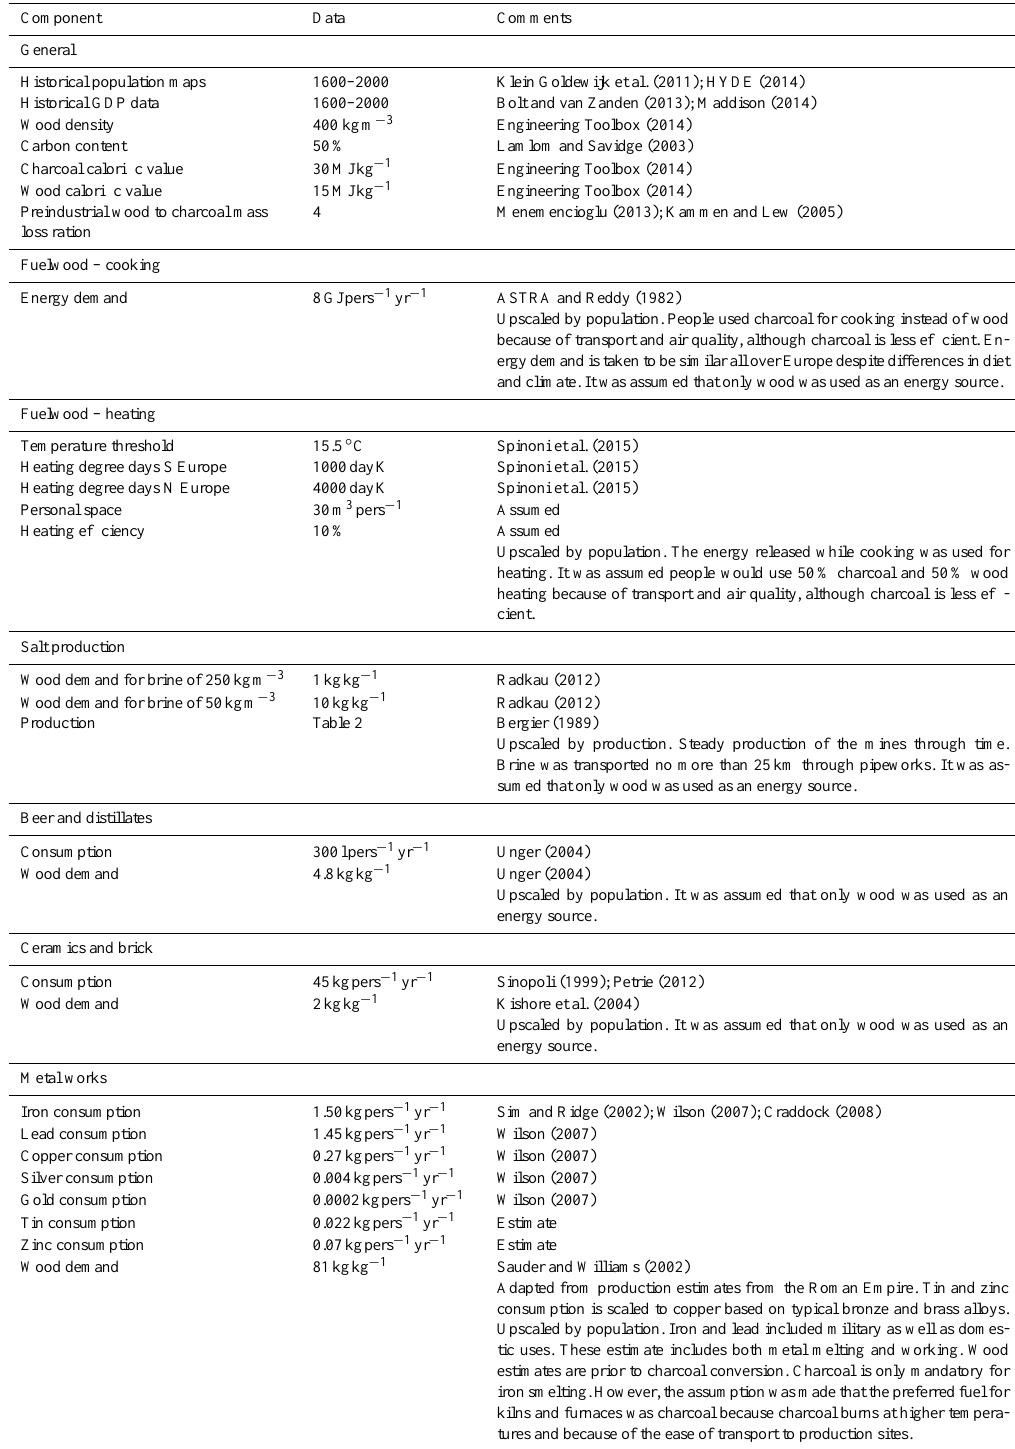
Table 1. Summary of various data sources used to reconstruct forest management between 1600 and 2010. The years listed are the years of the data set which were used in this work, not necessarily all the years available. The following abbreviations were used: GDP for gross domestic product, pers for person, live for head of livestock, S for southern, C for central and N for northern.